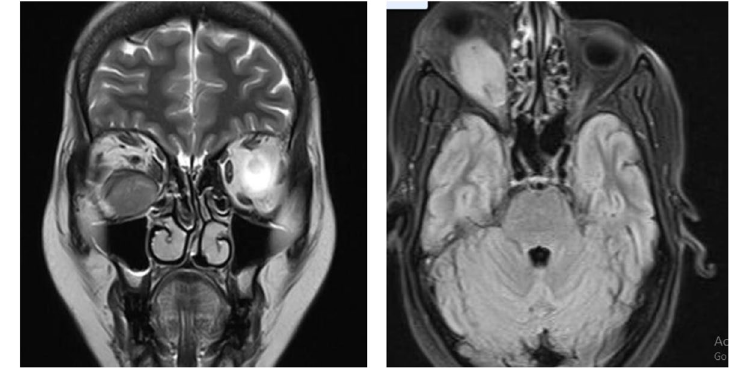
Fig. 2 Contrast-enhanced MRI showing mass arising from the inferior rectus muscle just abutting the optic